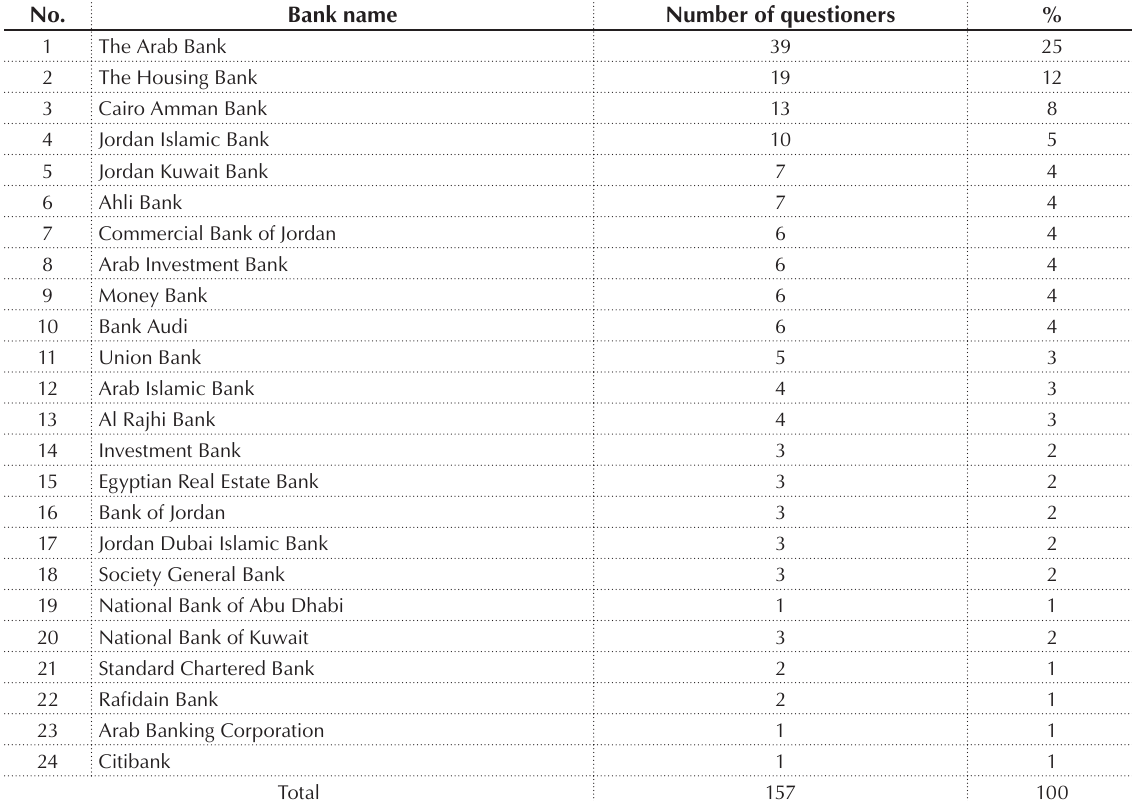
Table 1. (cid:94)(cid:381)(cid:272)(cid:349)(cid:286)(cid:410)(cid:455)(cid:3)(cid:258)(cid:374)(cid:282)(cid:3)(cid:400)(cid:258)(cid:373)(cid:393)(cid:367)(cid:286)(cid:3)(cid:381)(cid:296)(cid:3)(cid:410)(cid:346)(cid:286)(cid:3)(cid:400)(cid:410)(cid:437)(cid:282)(cid:455)(cid:3)(cid:894)(cid:374)(cid:437)(cid:373)(cid:271)(cid:286)(cid:396)(cid:3)(cid:381)(cid:296)(cid:3)(cid:271)(cid:258)(cid:374)(cid:364)(cid:400)(cid:853)(cid:3)(cid:396)(cid:286)(cid:272)(cid:381)(cid:448)(cid:286)(cid:396)(cid:349)(cid:286)(cid:400)(cid:3)(cid:258)(cid:374)(cid:282)(cid:3)(cid:393)(cid:286)(cid:396)(cid:272)(cid:286)(cid:374)(cid:410)(cid:258)(cid:336)(cid:286)(cid:895)